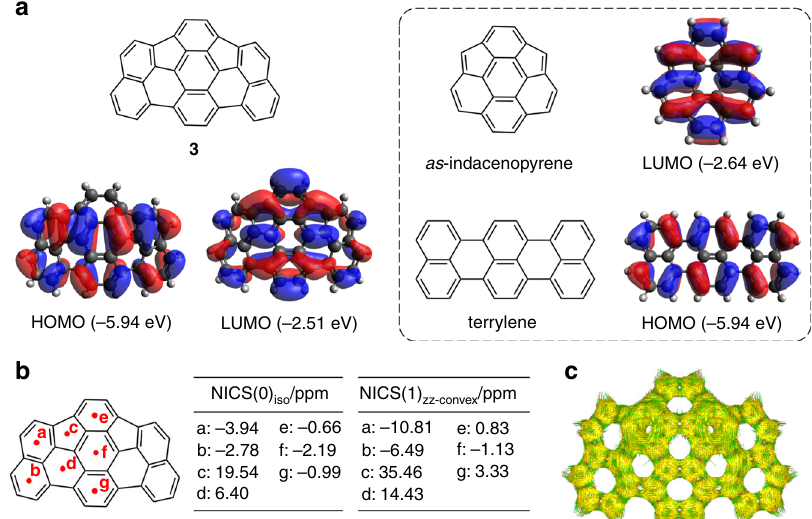
Fig. 4 Computational results for the electronic structure of as -indacenoterrylene 3. a HOMO and LUMO of 3 . Inset: HOMO of terrylene and LUMO of as -indacenopyrene. b NICS values of 3 . c ACID plot of 3